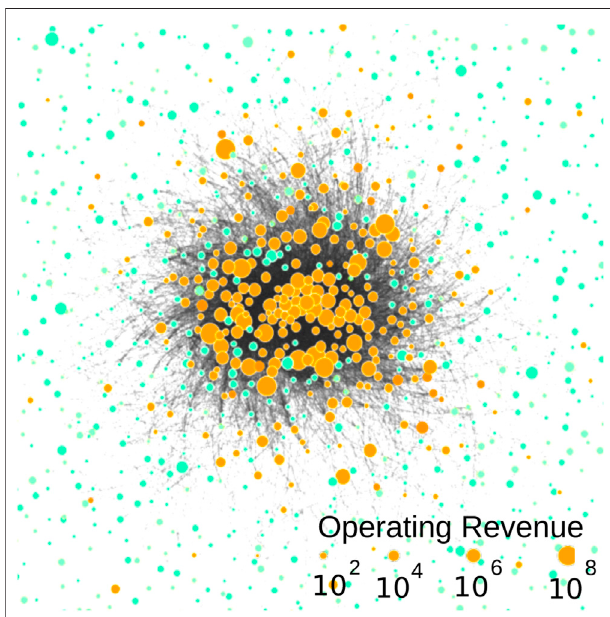
FIGURE 1 | Visualization of the densely connected core of the global ownership network of 1,318 fi rms. Transnational companies (TNCs) are shown in orange, and participated companies (PCs) are shown in light green nodes. The size of each node is scaled according to the operating revenueof the fi rm. Note that fora visualization purpose, weonly keep 33%of the edges with the largest weight.